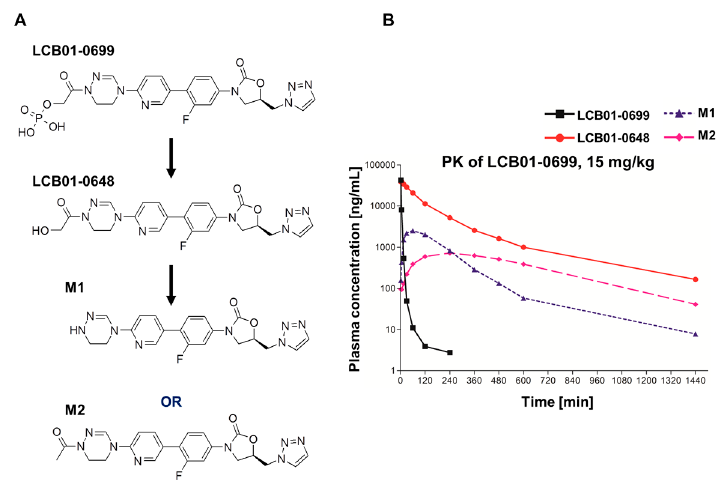
Figure 2. ( A ) Proposed biotransformation of LCB01-0699 ; ( B ) Average (±SD) plasma concentration of LCB01-0699 and their metabolites versus time plots of 24 subjects after administration of 15 mg/kg LCB01-0699 .